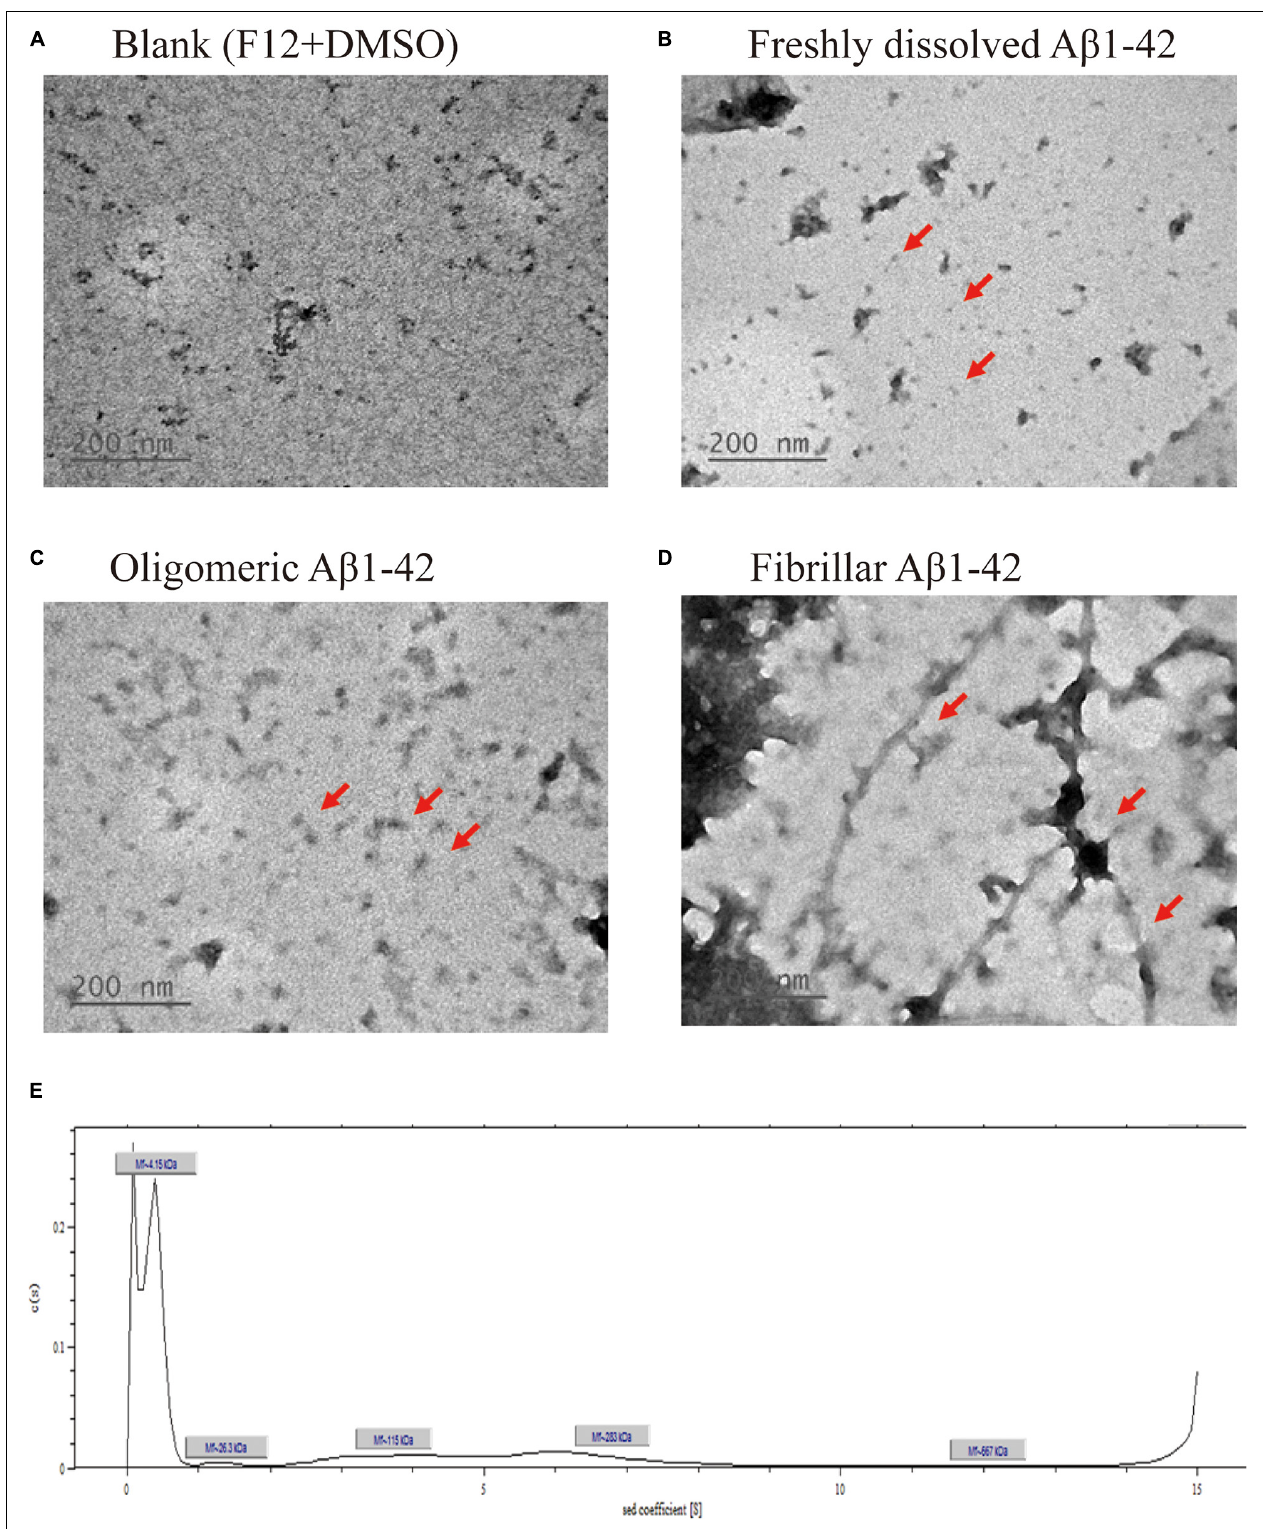
FIGURE 1 | Transmission electron microscopy (TEM), morphological and analytical ultracentrifugation (AUC), and physical characterization analysis of prepared beta-amyloid (A β 1 − 42 ). TEM image of (A) blank [F12 medium + dimethyl sulfoxide (DMSO)], (B) freshly dissolved A β 1 − 42 , (C) oligomeric A β 1 − 42 , (D) fibrillar A β 1 − 42 , and (E) Sedimentation coefficient analysis of oligomeric A β 1 − 42 using AUC.